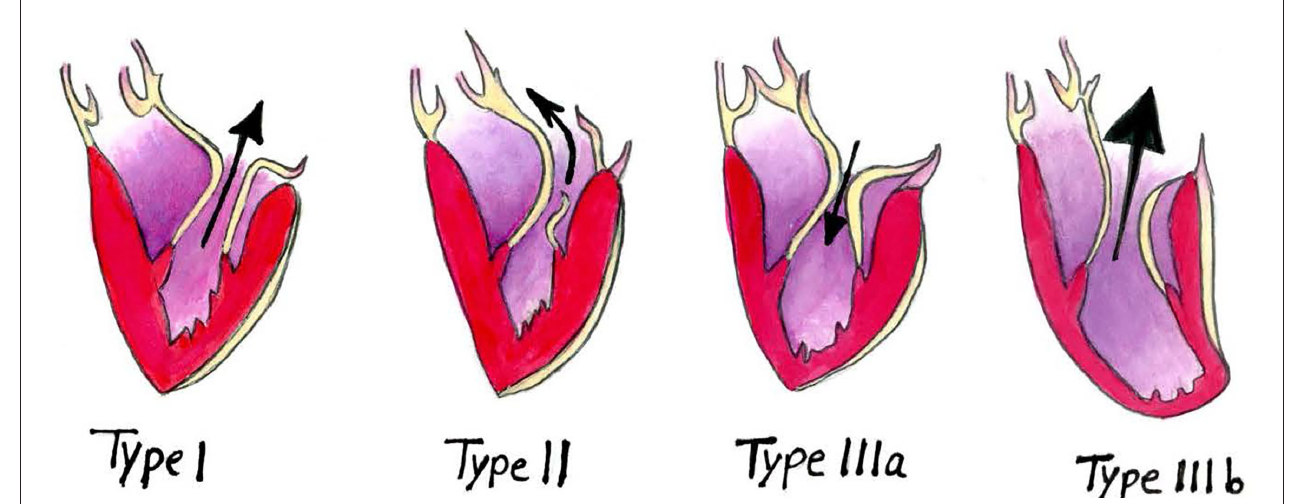
FIGURE 3 | Carpentier’s classification of mitral regurgitation. The arrows represent the direction of the blood